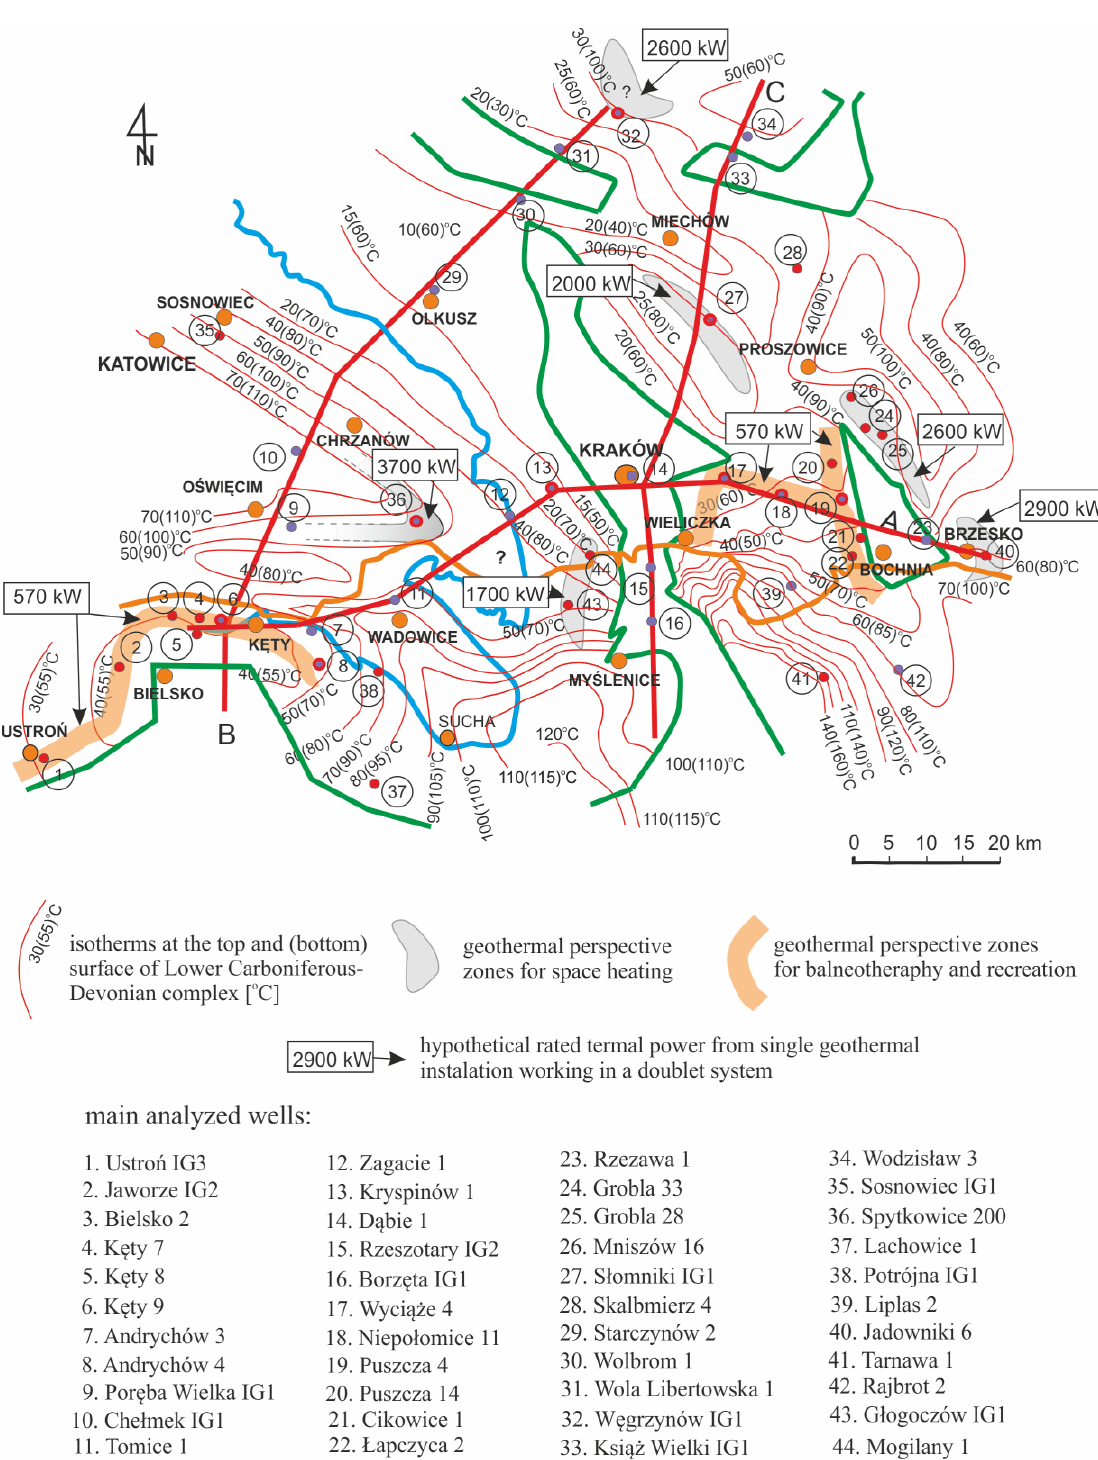
Figure 7. Map of temperatures at the top/bottom surface of the Lower Carboniferous–Devonian complex in the analyzed part of the Silesia–Krakow region, well numbers as in Table 1 (based on PIG borehole data, and according to